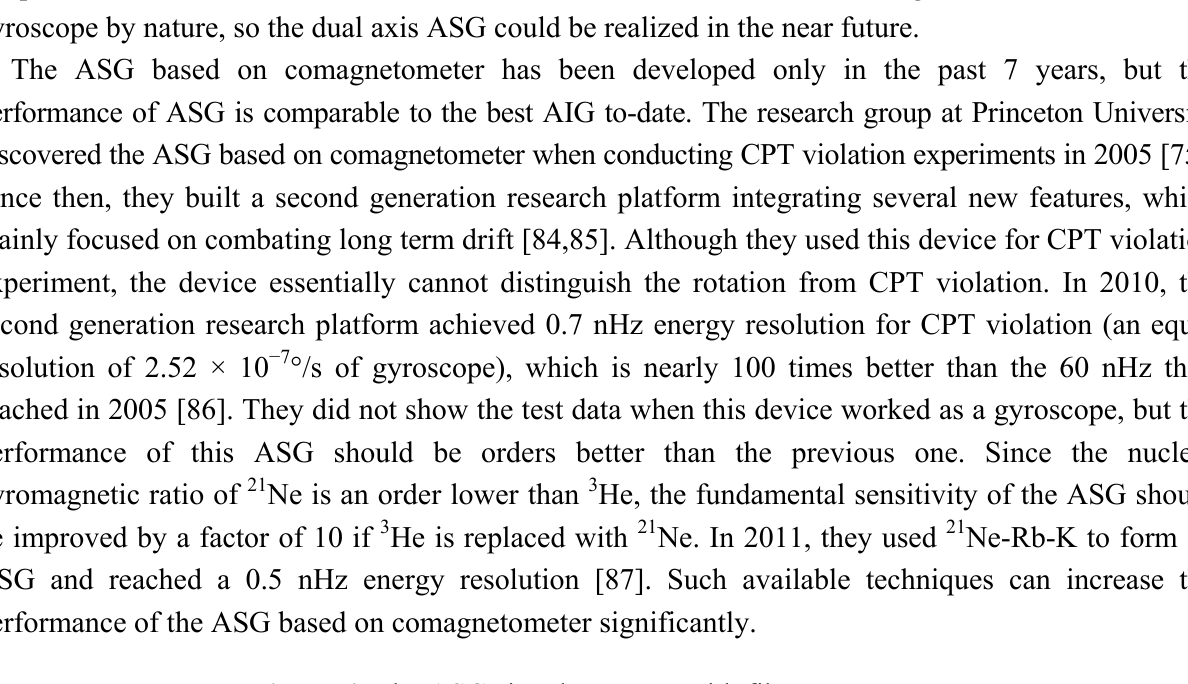
Figure 4. The ASG signal compare with fiber gyroscope.